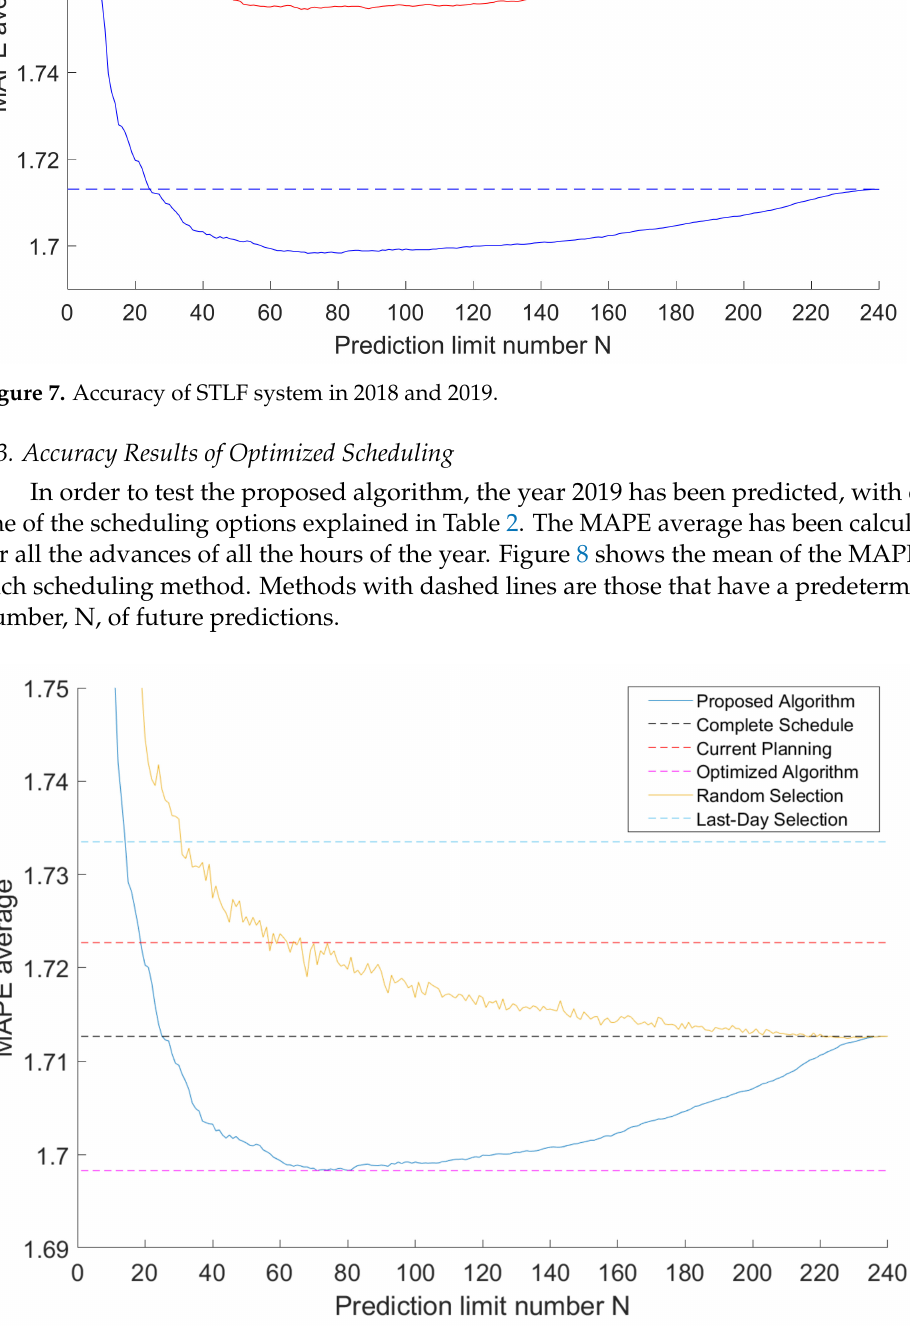
Figure 8. Accuracy of STLF system with different